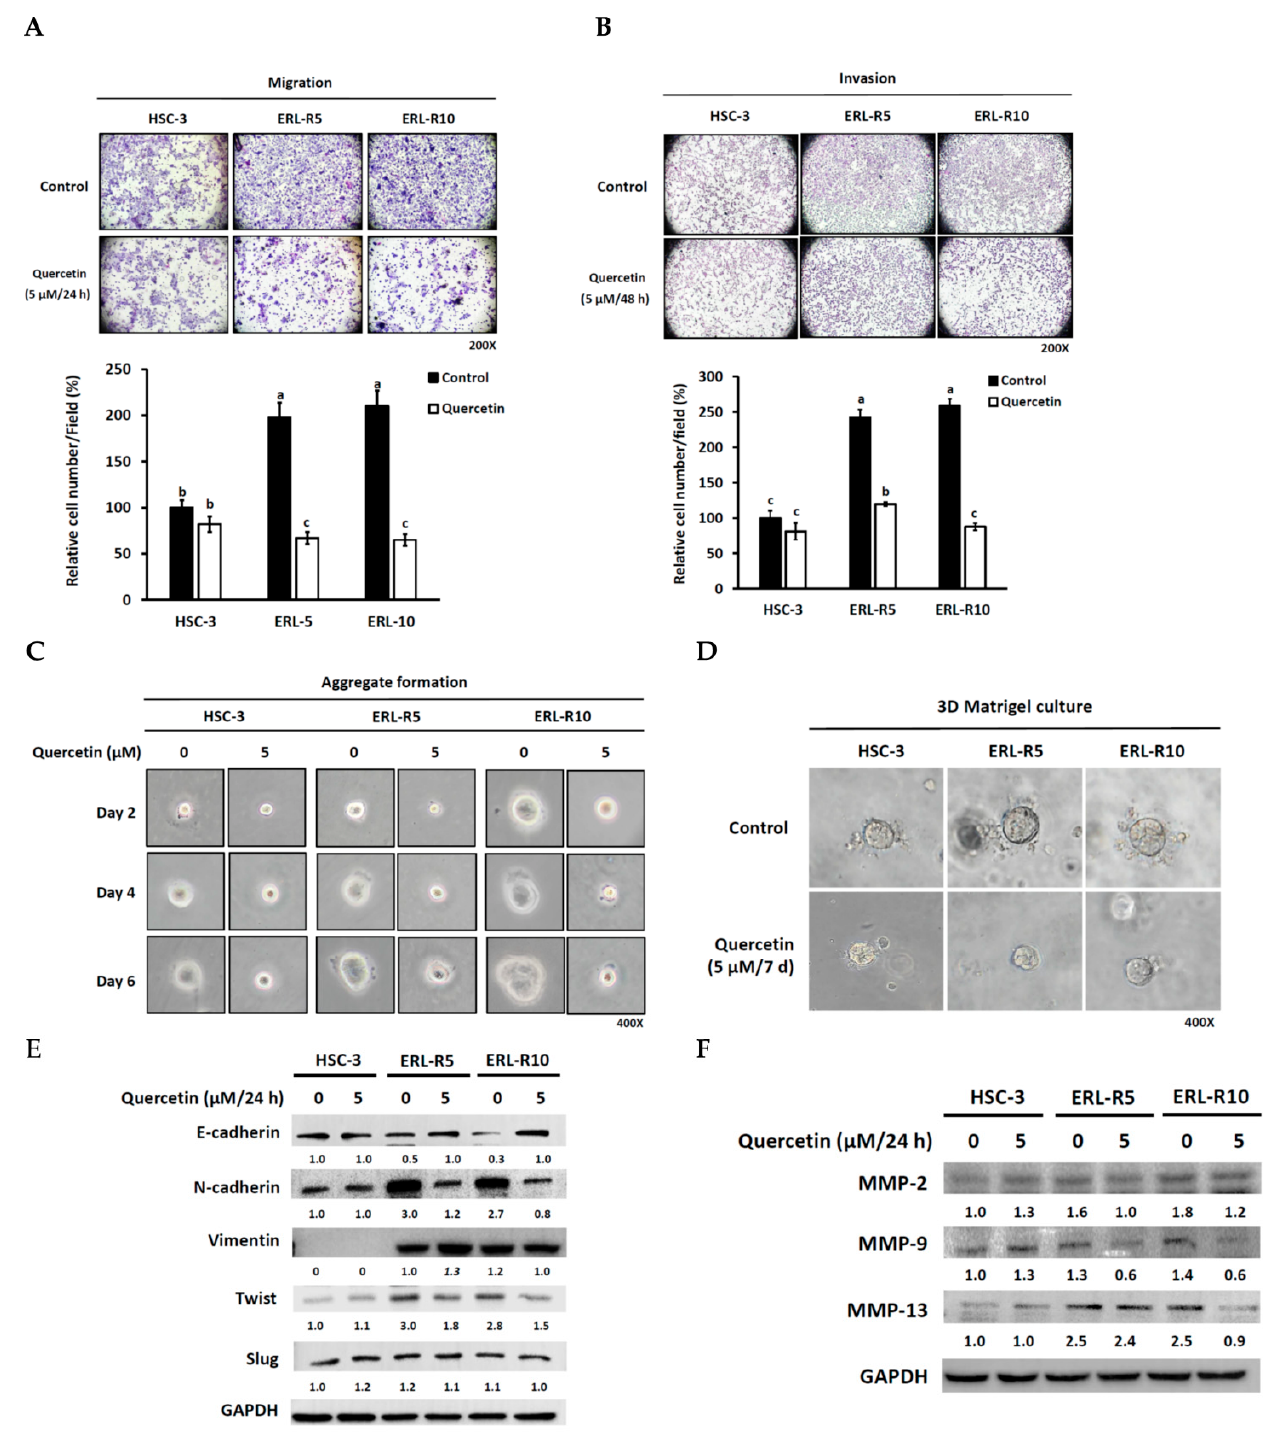
Figure 4. The aggressive phenotype of erlotinib-resistant OSCC cells is sensitive to quercetin. ( A – D ) Impact of quercetin on cell ( A ) migration, ( B ) invasion, ( C ) aggregation, and ( D ) sphere formation of erlotinib-resistant cells. HSC-3, ERL-R5, and ERL-R10 cells were plated in the upper chamber in a serum-free medium with or without quercetin (5 μ M) and allowed to ( A ) migrate or ( B ) invade for 24 h with the addition of a chemoattractant (10% fetal bovine serum-containing medium) in the lower chamber. Cells that migrated or invaded to the other side of membrane were photographed under 200X magnification and counted in three randomly selected microscopic fields. Values are mean ± SD, n = 3. abc Values with different letter differ significantly at indicated time point, p < 0.05. ( C ) HSC-3, ERL-R5, and ERL-R10 (2 × 10 3 cells) were seeded into low adhesive 35-mm culture dishes and cultured in regular growth media with or without 5 μ M quercetin at 37 °C under 5% ( v / v ) CO 2 .